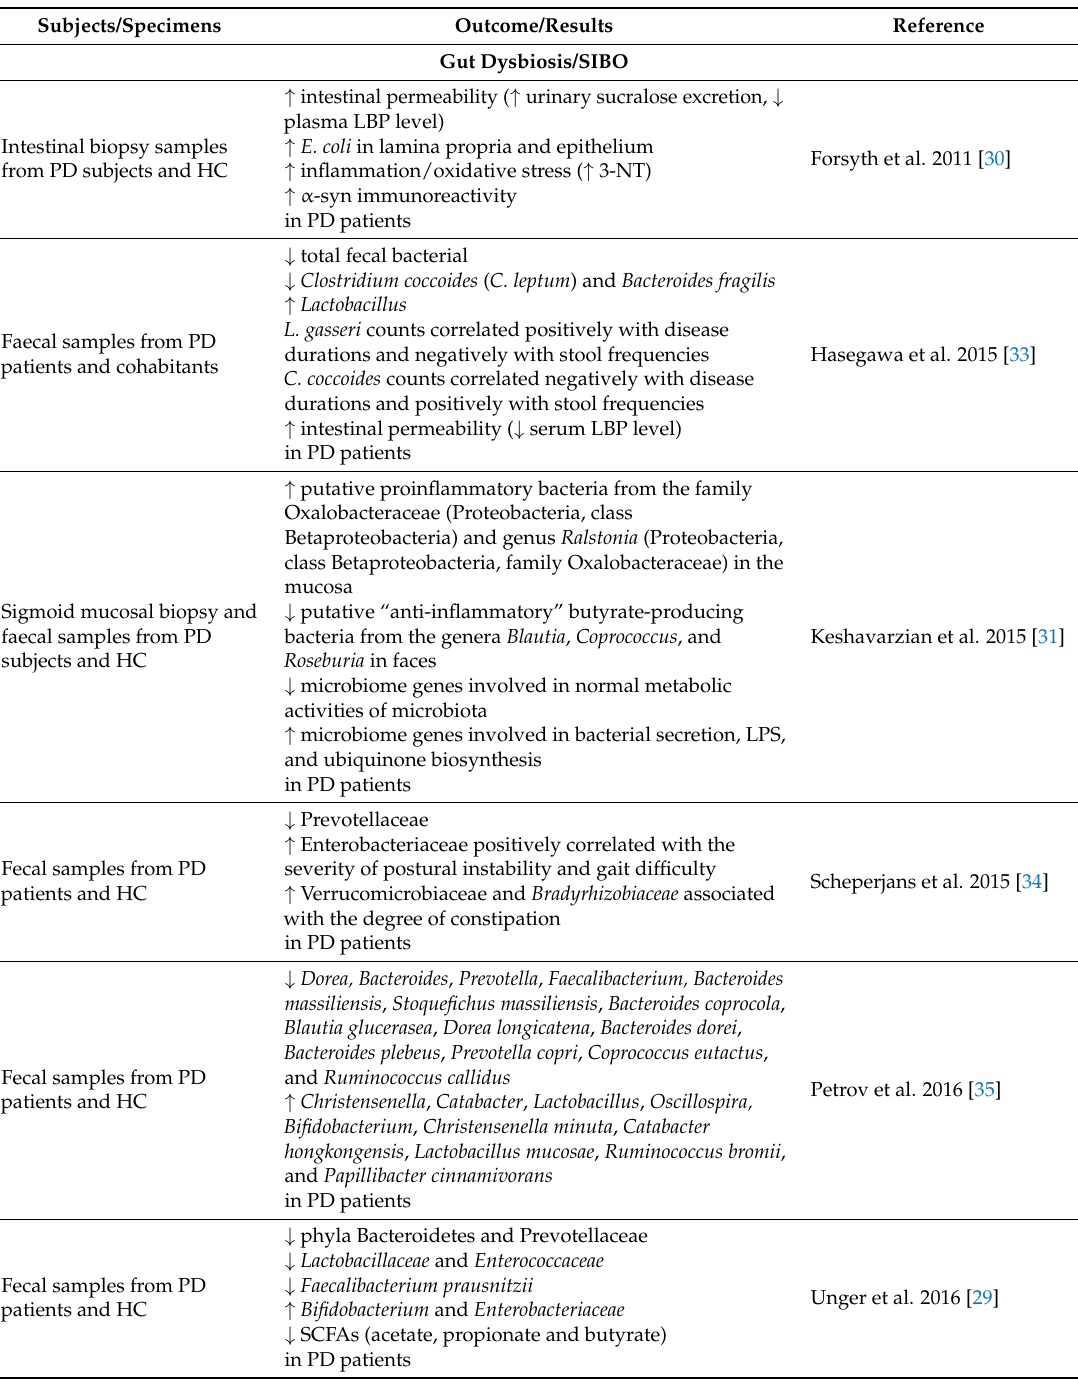
Table 1. Summary of evidence from research in human subjects for concepts of the gut-brain axis and the prion-like spreading/propagation of α -synuclein in Parkinson’s